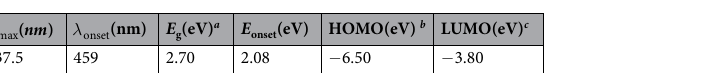
1240 56 . b The HOMO energy levels were determined λ onset